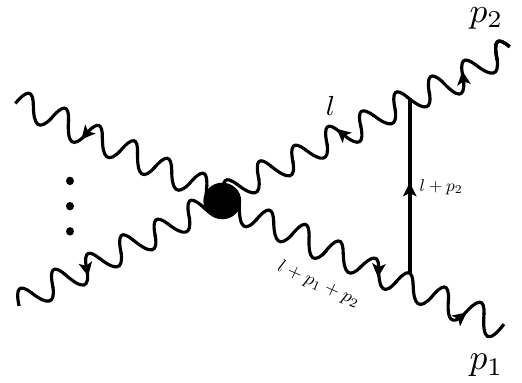
Figure 10 . One-loop corrections to ( F k ) L